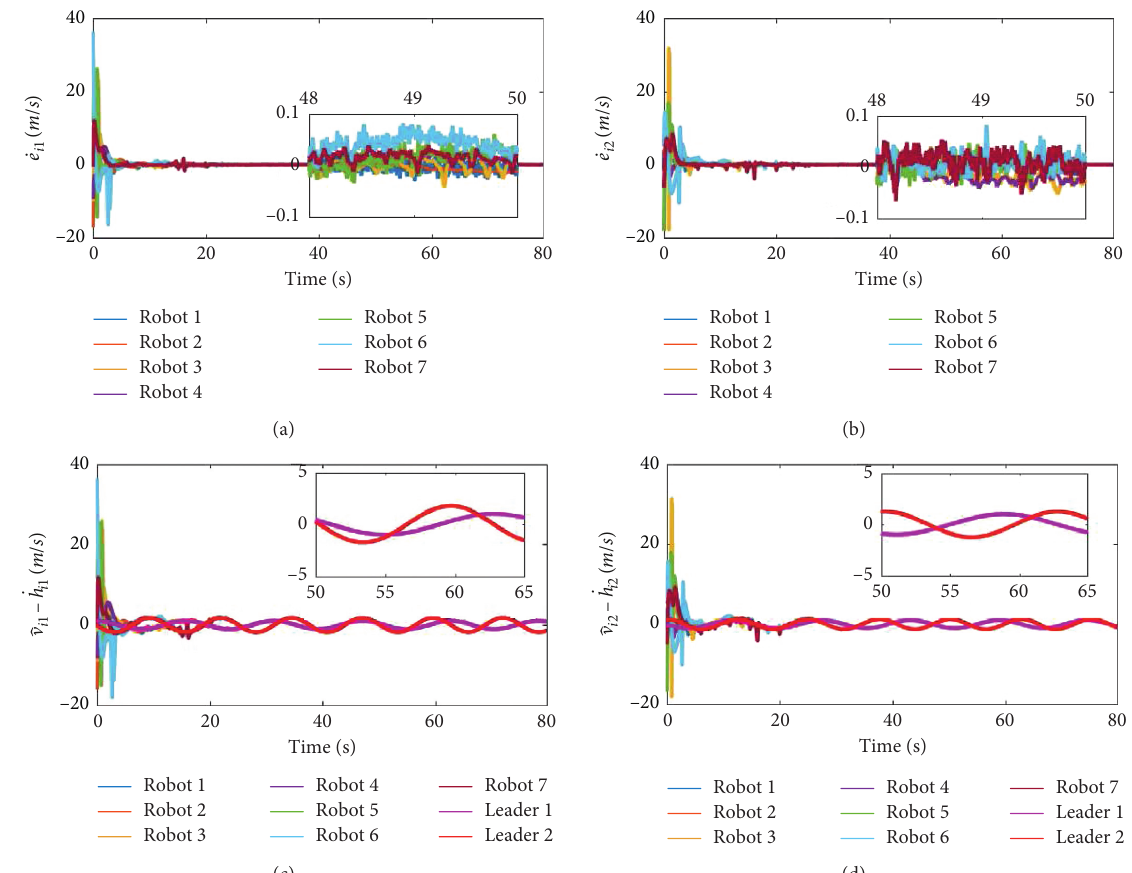
Figure 12: Evolution of _ e